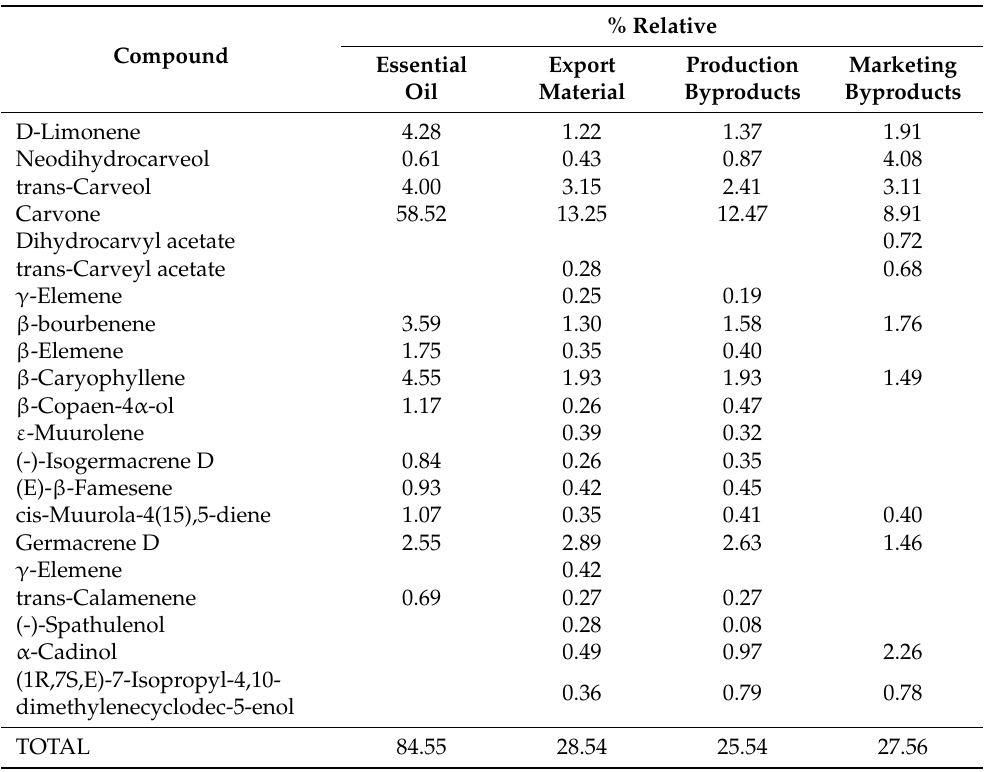
Table 3. Comparison of export material and byproducts in relation to terpenoids commonly present in the essential oil of spearmint. % Relative Compound Essential